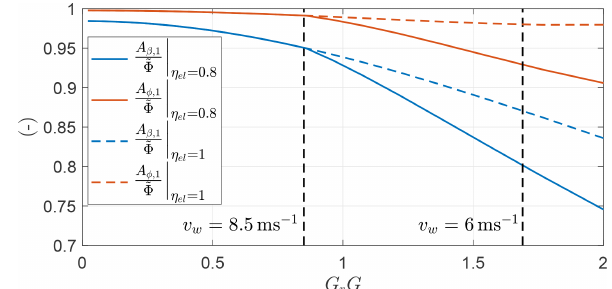
Figure 29. Optimal values of ˆ γ and A γ, 1 as a function of G r G .